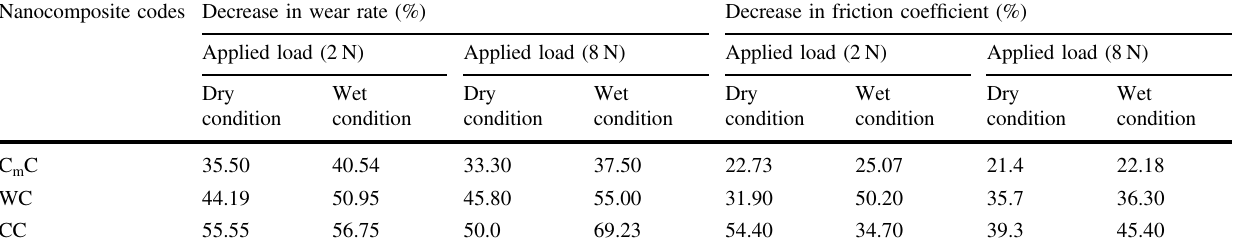
Table 4 Percent decrease in the wear rate and friction coef fi cient of the composites C m C, WC, and CC having an optimum concentration of the fi ller particles with respect to AR Nanocomposite codes Decrease in wear rate (%)